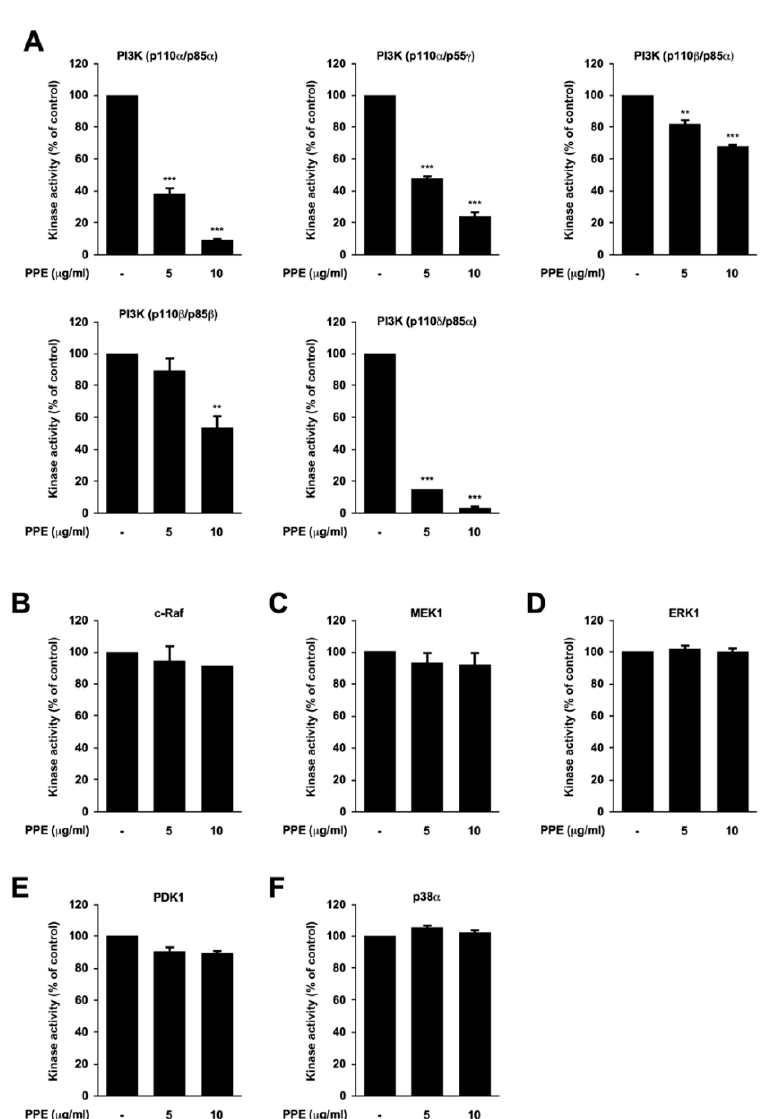
Figure 4. Propolis extract selectively attenuates phosphoinositide 3-kinase (PI3K) activity. Kinase activity of ( A ) PI3K isoforms; ( B – F ) c-Raf, mitogen-activated protein kinase (MAPK)/ERK kinase 1